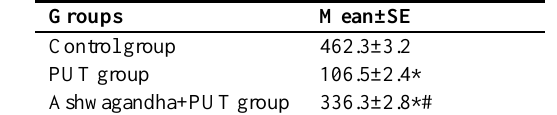
Table 2 : Mean thickness (µm) of growth plate cartilage (±SE) in the studied groups Groups Mean±SE Control group